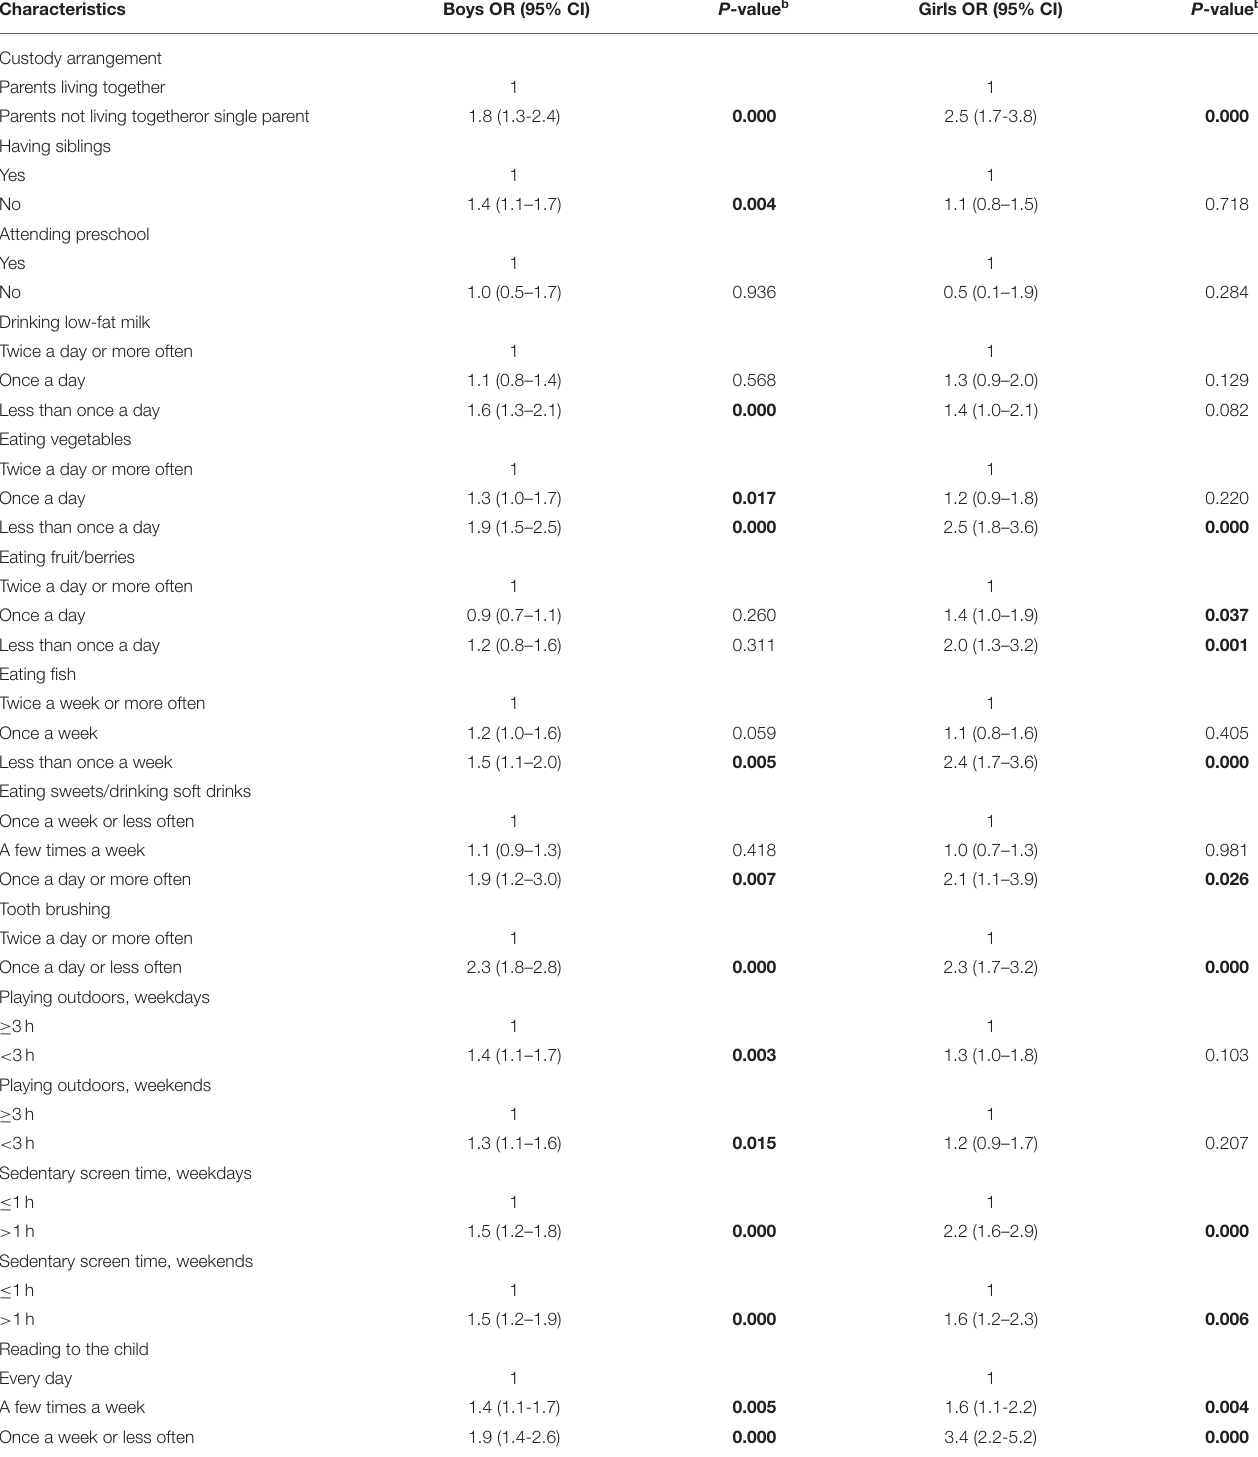
TABLE 2 | Associations between 3-year-olds’ lifestyle and social-emotional problems as measured by ASQ:SE a using simple logistic regressions.